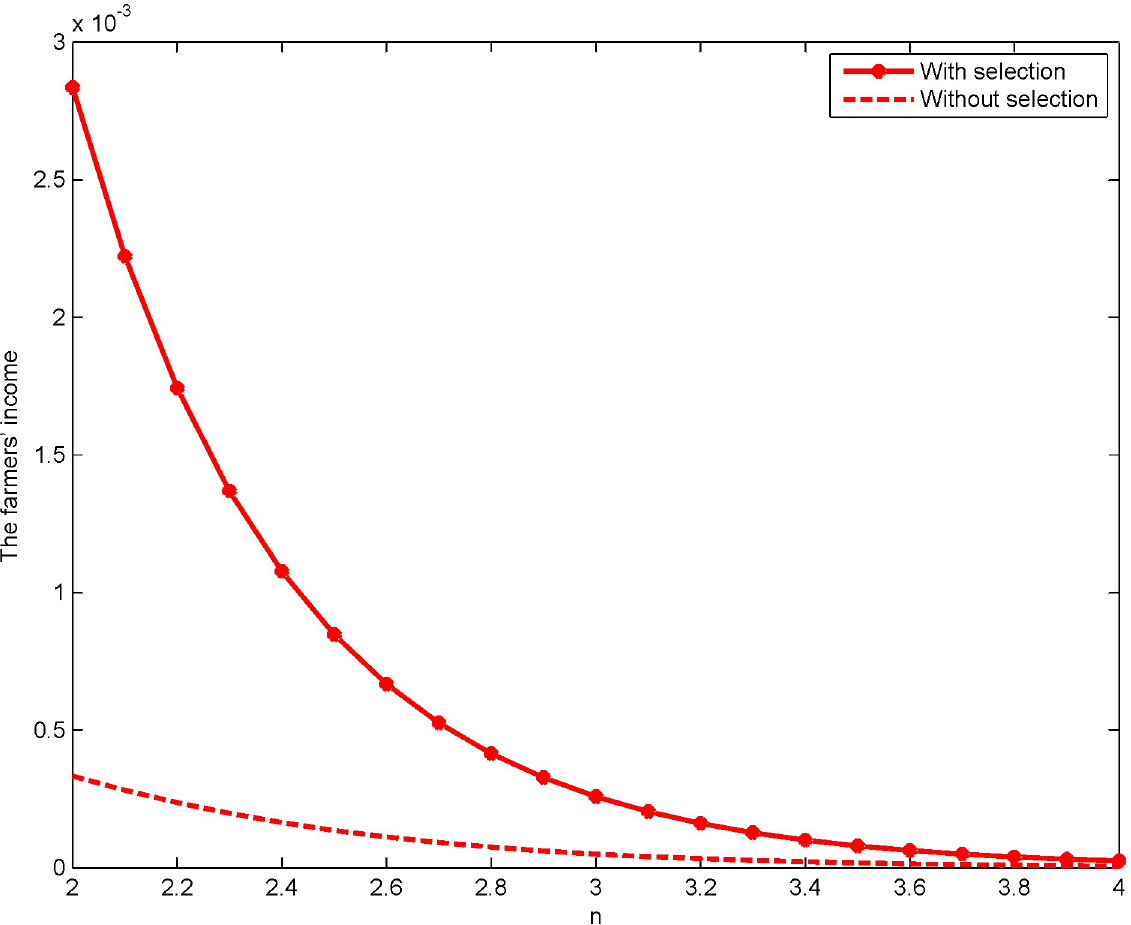
Fig 5. Impact of n on farmers’ income for the second-price sealed-bid